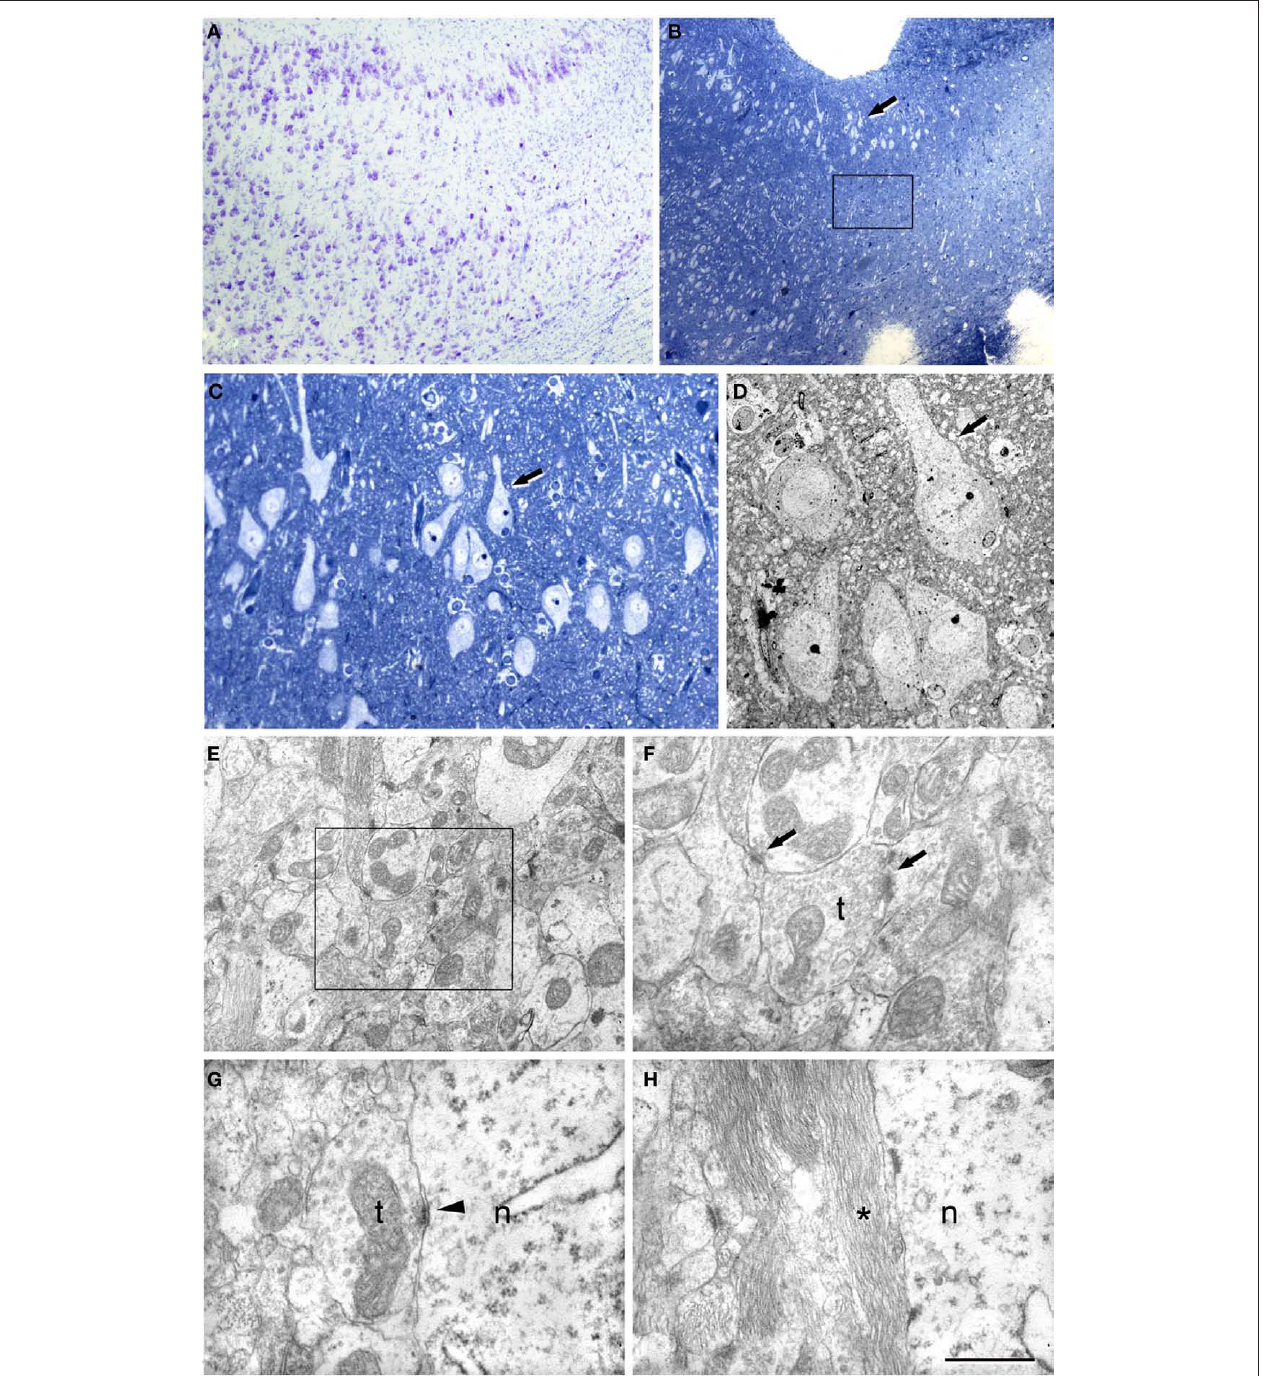
(B,C) that illustrates the same group of pyramidal neurons. (E) Electron micrograph of the neuropil showing numerous synapses. (F) Higher magnification of the boxed area in (C) showing two synapses. (g, H) High power electron micrographs to illustrate the presence of symmetric synapses on a neuronal cell body (g) and the presence of the glial processes around them (H) ; n, neuronal cell body; t, axon terminal. Scale bar [in (H) ]: 430 μm in (A) , 340 μm in (B) , 75 μm in (C) , 19 μm in (D) , 1.6 μm in (E) , 0.8 μm in (F) , 0.7 μm in (g) , and 0.8 μm in (H)